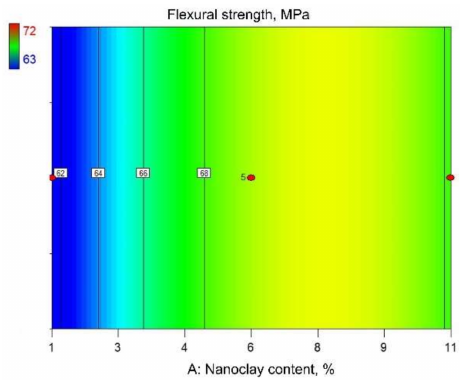
Figure 7. Contour view of reduced quadratic regression model: flexural